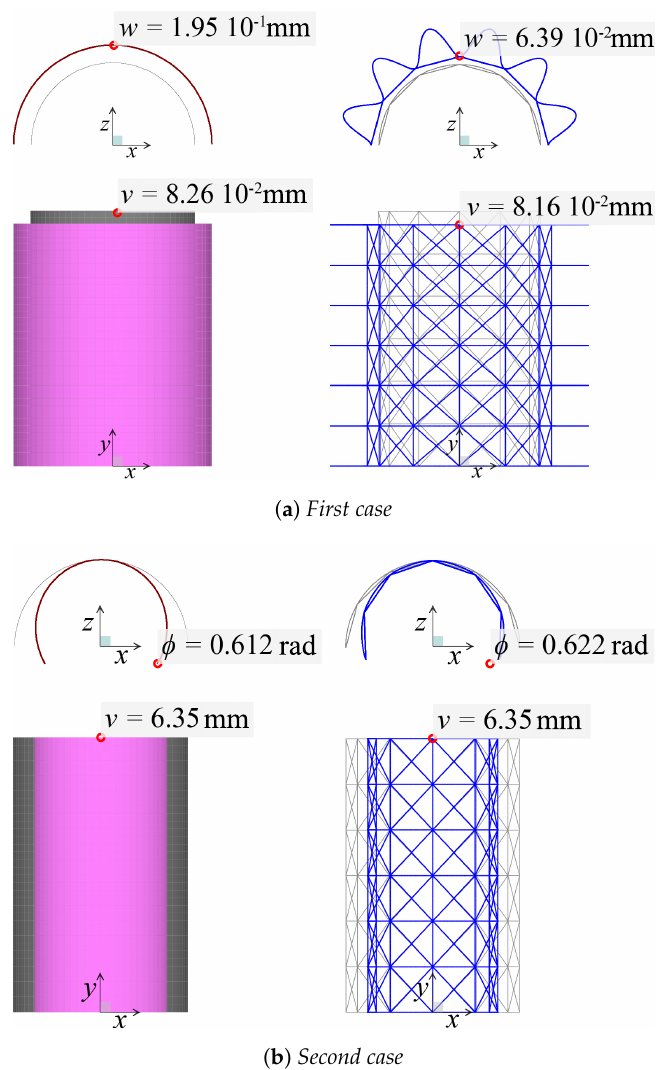
Figure 13. Deformed